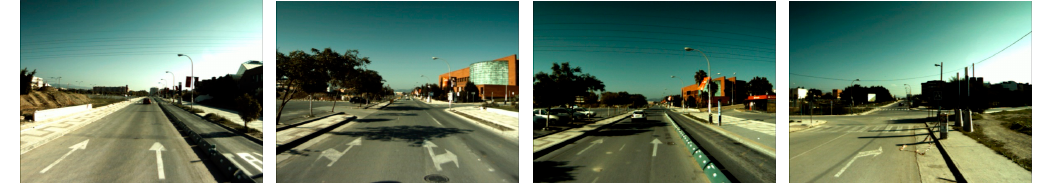
Figure 5. Example images from Málaga dataset 2009.